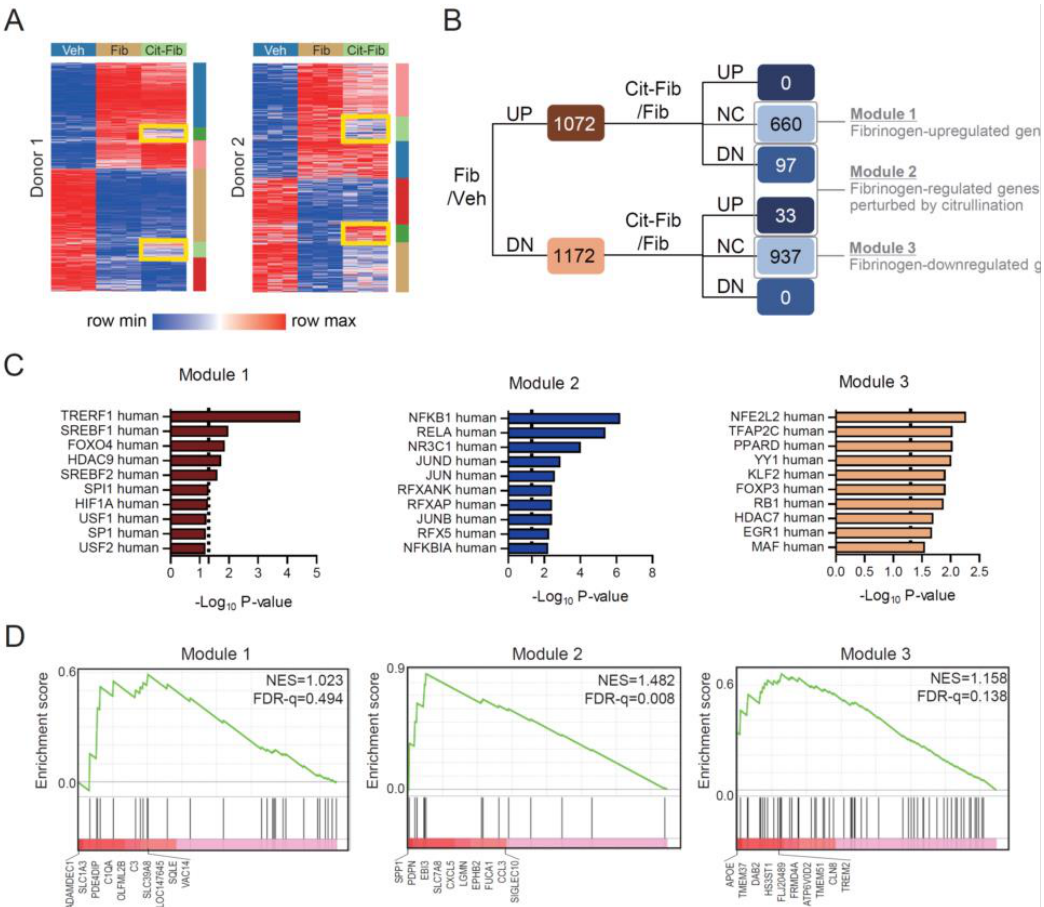
Figure 2. Differentially expressed genes (DEGs) in CD14+ sorted monocytes from two peripheral blood donors in the presence of fibrinogen or citrullinated fibrinogen. ( A ) Heatmap of DEGs. Veh = vehicle, Fib = bovine fibrinogen, Cit-Fib = bovine fibrinogen citrullinated by PAD2. Six different clusters of DEGs were presented by K-means clustering analysis. Yellow boxes indicate the clusters associated with restoration of fibrinogen-induced change by citrullination. ( B ) Fibrinogen-regulated genes perturbed by citrullination correspond to DEGs in the yellow box in ( A ). UP = upregulated genes, NC = no change in expression, DN = downregulated genes. ( C ) Gene set enrichment analysis of the module 1, 2, or 3 using the human TRRUST transcription factor database. Dashed line = p -value 0.05. ( D ) Gene set enrichment analysis of the module 1, 2, or 3 using osteoclast-specific gene set originated from ref. 21. NES = normalized enrichment score, FDR-q = q-value of false discovery rate.